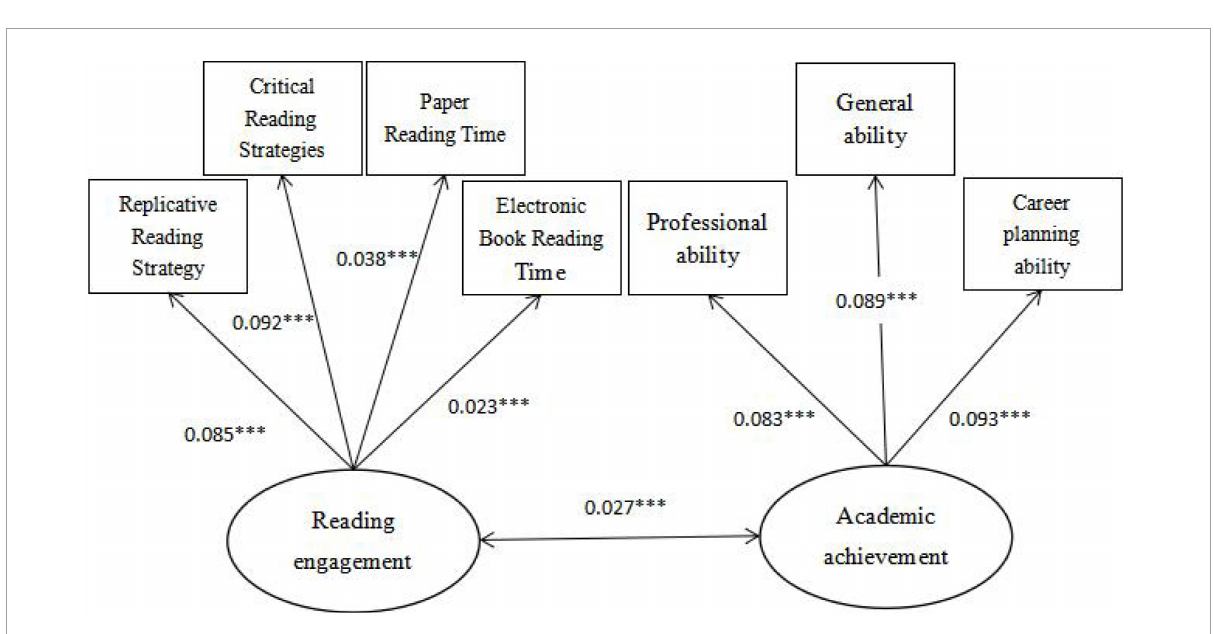
FIGURE2 Construct validity analysis diagram of reading input (after standardization). Significance level * P < 0.1, ** P < 0.05, and *** P < 0.01.